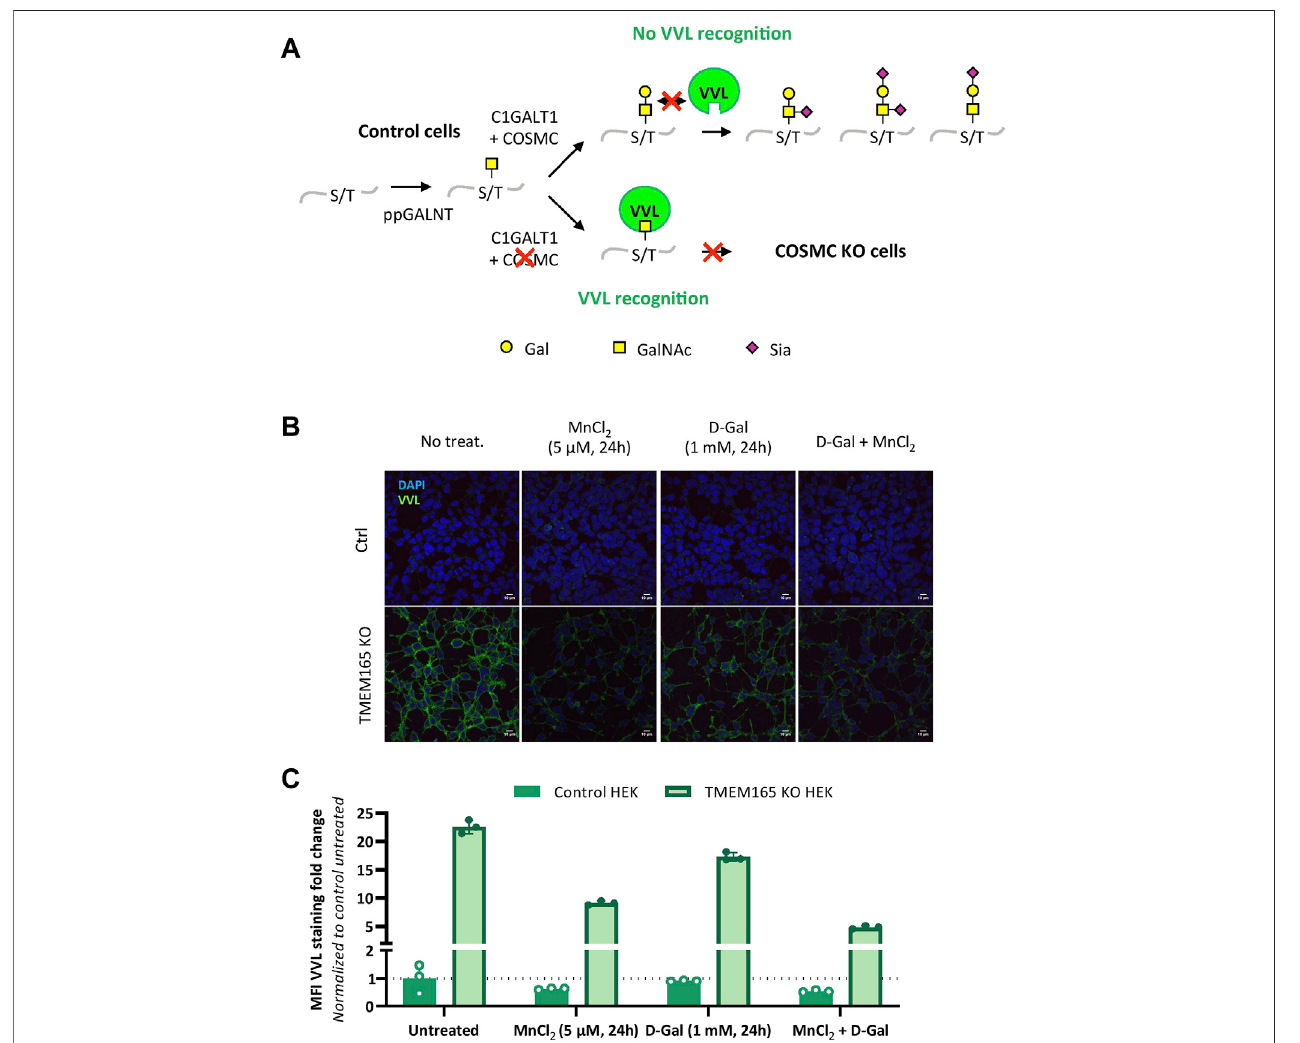
FIGURE 3 | O -linked mucin-type defects in TMEM165 KO HEK cells. (A). Schematic representation of the initiating steps of core 1 mucin-type O -glycan synthesis and speci fi c lectin recognition. First, a N -acetylgalactosamine (GalNAc) residue is linked to the hydroxyl group of a serine (S) or threonine (T) within a polypeptide via the activityofseveralpeptidylGalNActransferases(ppGALNT).Then,thegalactosyltransferaseC1GALT1catalyzestheadditionofagalactose(Gal)residueontoGalNAcfor furtherelongationbyacidsialic(Sia).C1GALT1requiresthechaperoneCOSMCtobefullyfunctional.VVLonlyrecognizesfreeterminalGalNAcresidues.Incaseof COSMC de fi ciency, GalNAc residues are no longer substituted and thus accessible to VVL. Symbols used to represent the different sugar residues are indicated at the bottom of the scheme. (B). In fl uence of MnCl 2 and/or D-Gal supplementations on VVL- fl uorescein staining in TMEM165 KO HEK cells. Cells were treated with the indicated treatments, fi xed and labeled with VVL- fl uorescein (green) before confocal microscopy visualization. DAPI staining (blue) was performed, showing nuclei. (C). Relativequanti fi cationofVVL- fl uoresceinstainingincells.Theresultsareexpressedasmean fl uorescenceintensity(MFI)percentagesobtainedafternormalizationofthe VVL- fl uorescence intensity to that of DAPI and considering the MFI of untreated control HEK cells as 1 ( n = 3; p value < 0.001).